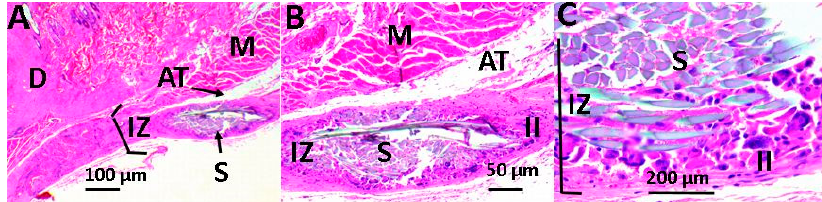
infiltrate, IZ: implantation area, and M: Muscle. Int. J. Mol. Sci. 2019 , 20 , x FOR PEER REVIEW